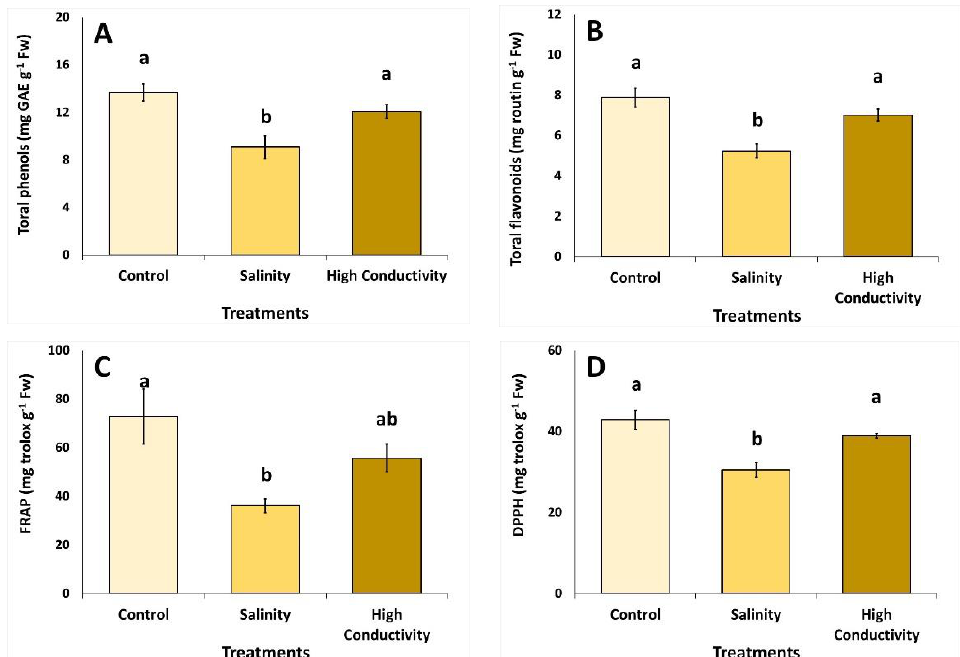
Figure 2. Influence of salinity (75 mM NaCl) and high electrical conductivity (8.5 dS m − 1 ) on ( A ) total phenols (mg GAE g − 1 fw), ( B ) total flavonoids (mg routin g − 1 fw) and antioxidant activity, assayed by ( C ) FRAP and ( D ) DPPH (mg trolox g − 1 fw) methods, on geranium plants grown hydroponically in perlite substrate. Significant differences ( p < 0.05) are indicated by different letters above each bar. Error bars show SE (n =